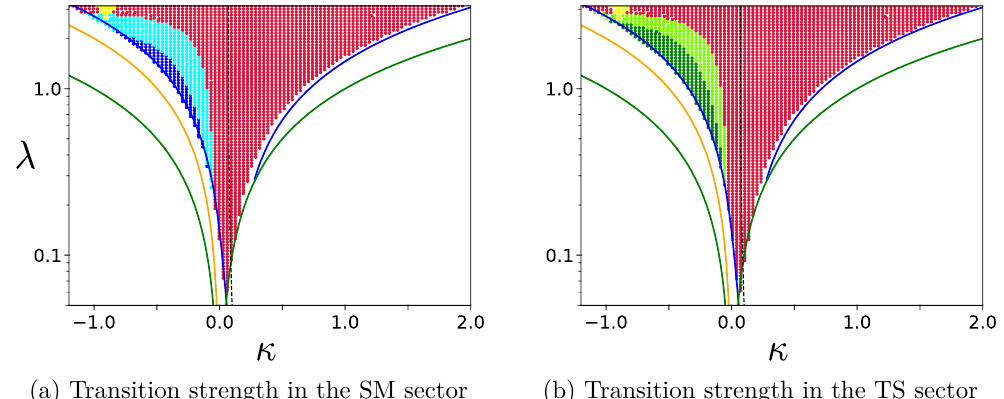
Figure 2. The strength of the phase transition in the TH model with Z 2 broken only in the Higgs potential in κ - λ plane for f 0 = 4 v A . The results for the SM (twin) Higgs are presented on the left (right) panel. The regions where the SM (twin) Higgs transition satisfies (4.2) is marked with dark blue (green) while the regions where transition fulfills (4.3) is plotted with cyan (lime). In the red region the transition was found very weak first-order or continuous. The yellow region is excluded because the 125 GeV scalar corresponds to twin instead of SM Higgs. The region above the green, blue and orange curves satisfy the corresponding bounds | κ | < λ , | ρ | < λ , and | σ | < λ . Black, vartical, dashed line corresponds to ρ = 0